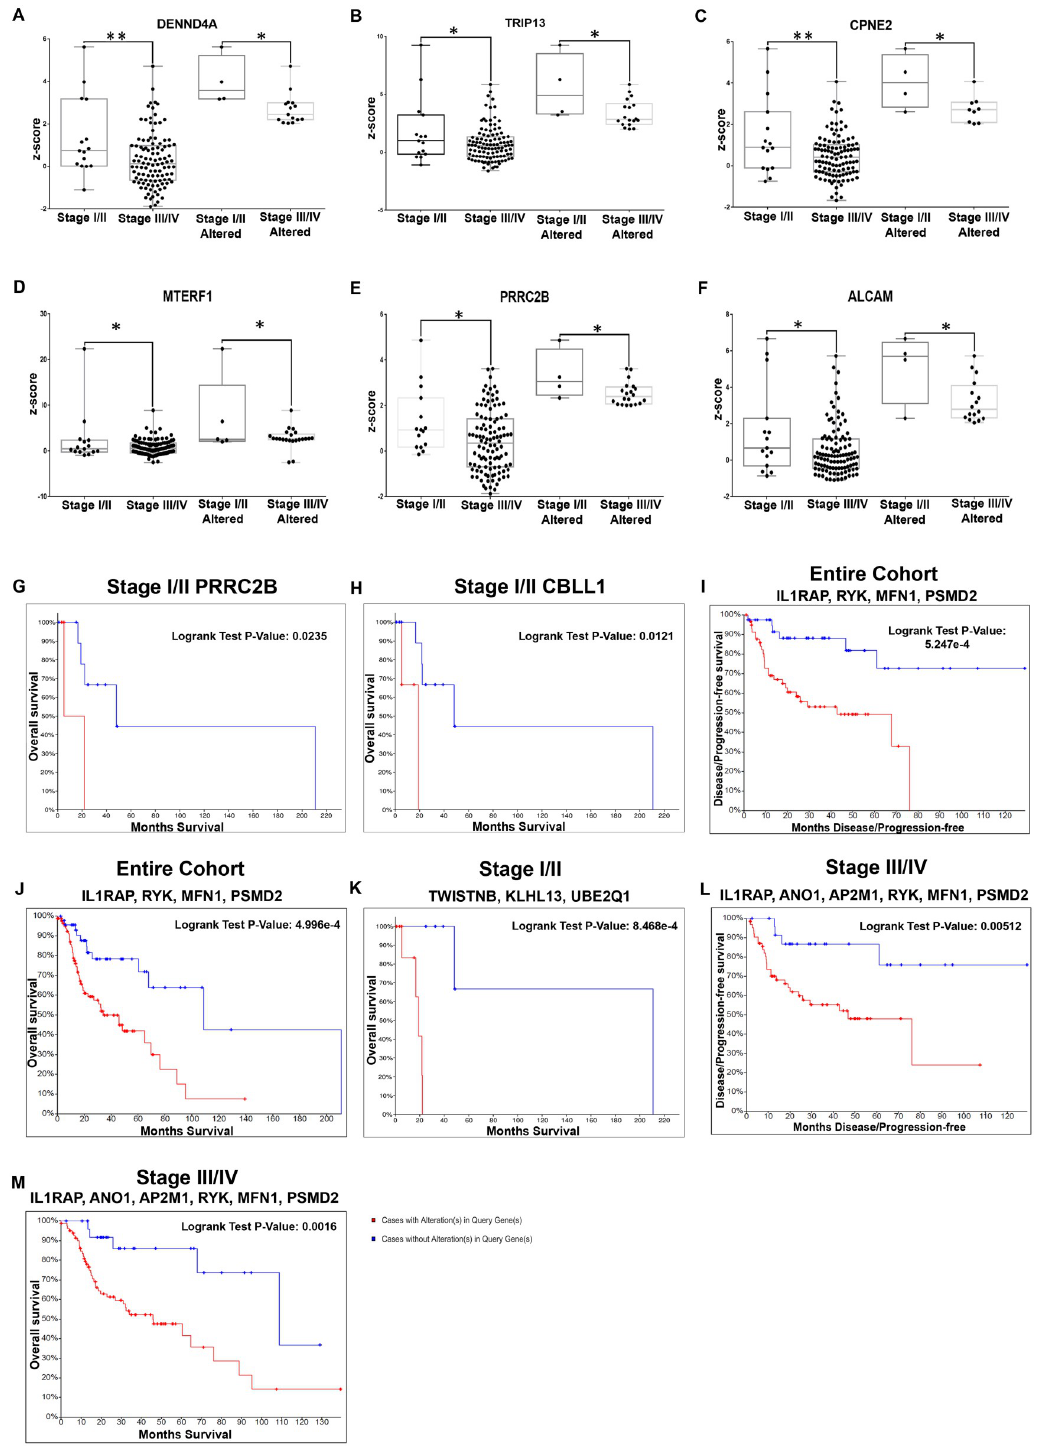
Fig 4. Molecular markers with significant differential expression and prognostic efficacy in laryngopharyngeal cancers. Meta-analysis based differentials in laryngopharyngeal cancers were validated in the TCGA cohort. mRNA expression levels (z- score) of the genes when compared stage-wise in the TCGA laryngopharyngeal cancer cohort identified 19 differentials in early stage cancers, the top six markers (DENND4A, TRIP13, CPNE2, MTERF1, PRRC2B and ALCAM) are represented here (A-F) . KM plot analysis of these genes in patients with early stage laryngopharyngeal cancers indicated PRRC2B ( G ; p = 0.023) and